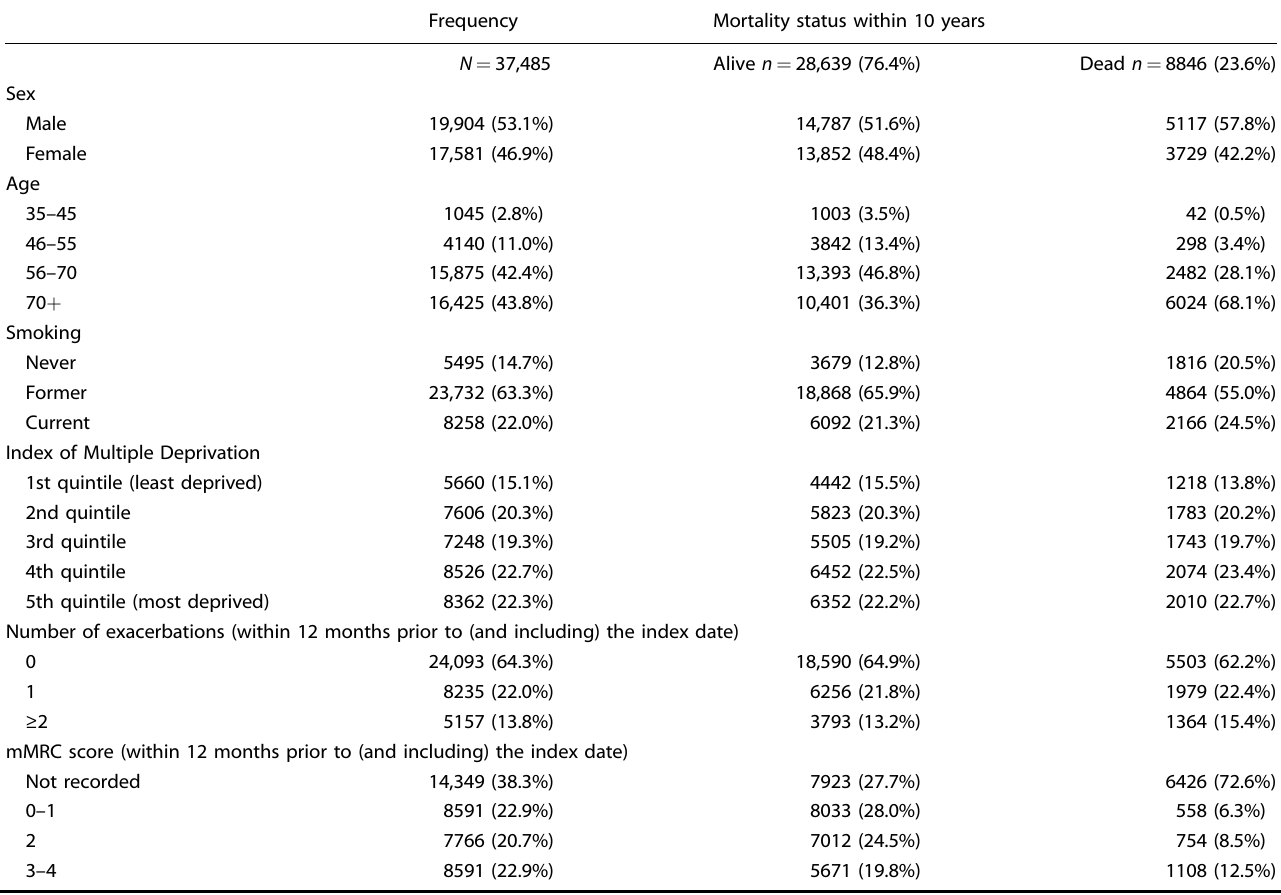
Table 1. Baseline characteristics of the COPD cohort in the study (total follow-up amounted to 149,196